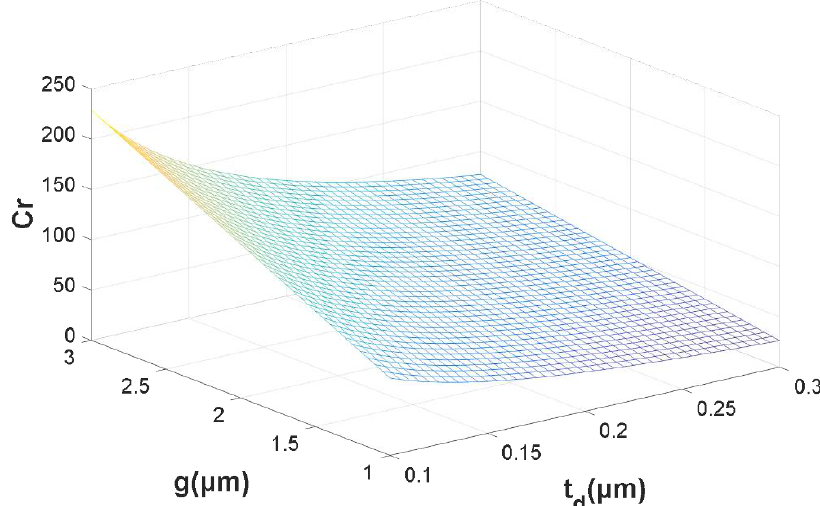
Figure 4. The relationship between g , t d and C r .